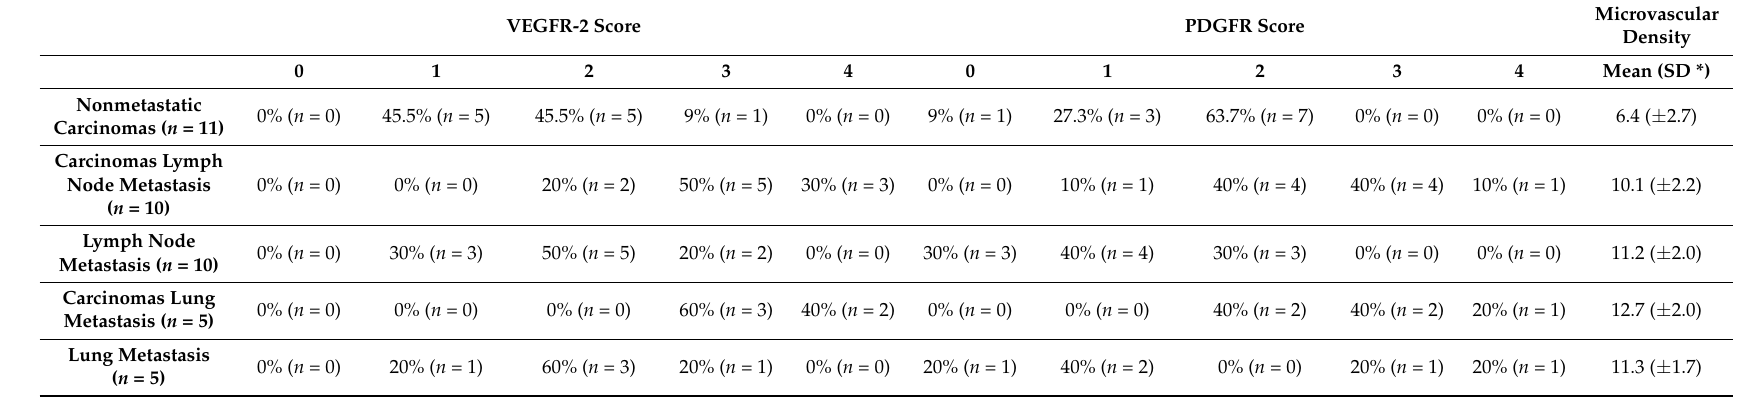
Table 2. Immunohistochemical evaluation of VEGFR-2, PDGFR, and microvascular density in canine mammary gland tumor